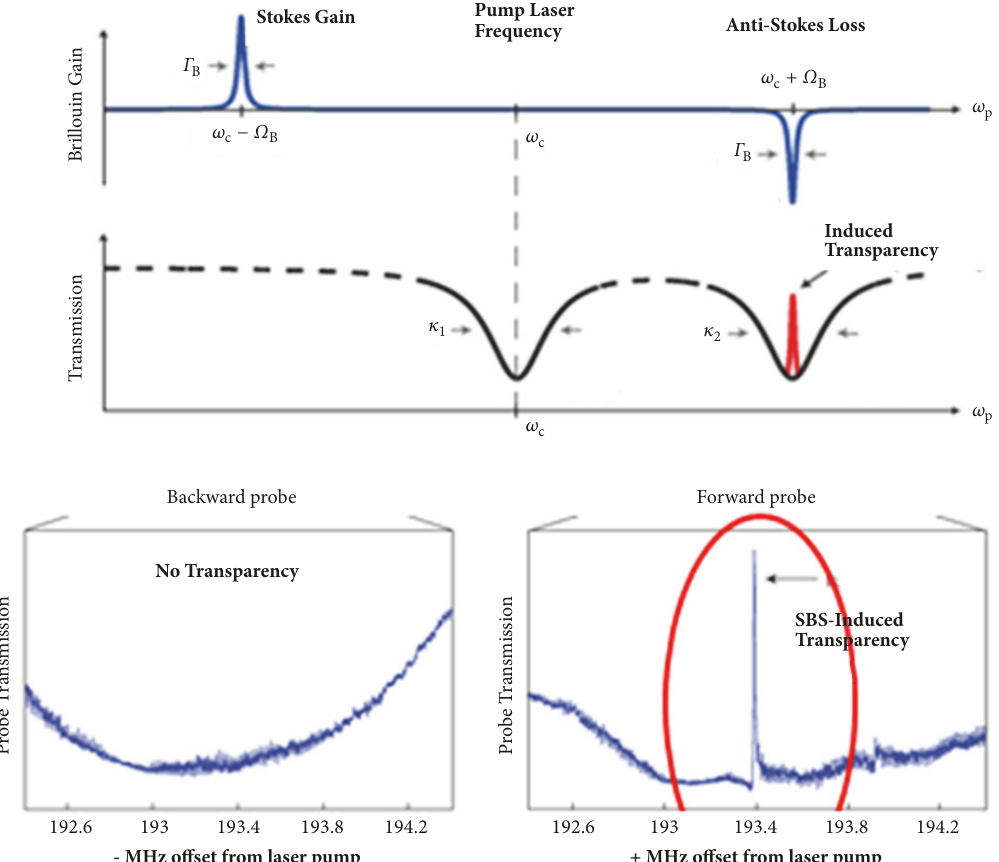
Figure 15: Demonstration of SBS-induced transparency in a micro-resonator.Top: Theory of Brillouin signal versus probefrequency; a probe at Stokes wavelength experiences gain, while loss is predicted for a probe signal at the anti-Stokes frequency.At high excitation levels, induced transparency is expected exactly on the Brillouin resonance. Bottom: when the phonon is long-lived, loss is observed at the Stokes frequency, while a probe at the anti-Stokes frequency experiences the predicted SBS-induced transparency [adapted from [18]].